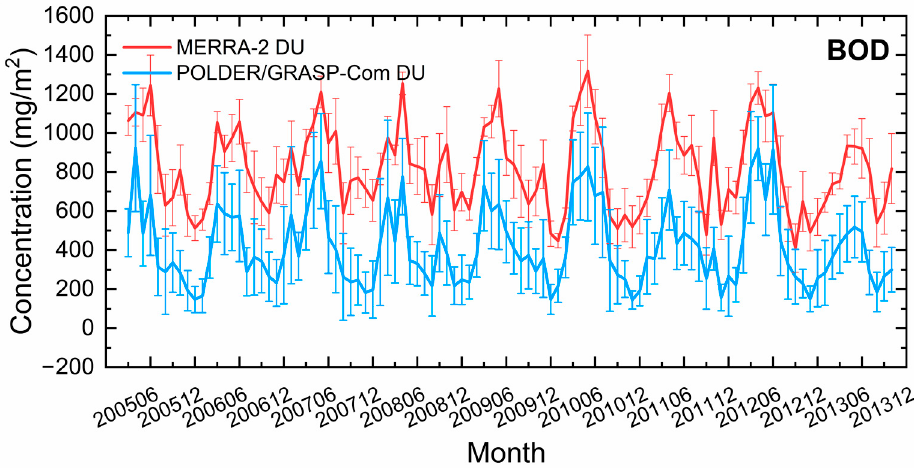
Figure 4. Same as Figure 3, but for Bodélé Depression (BOD)